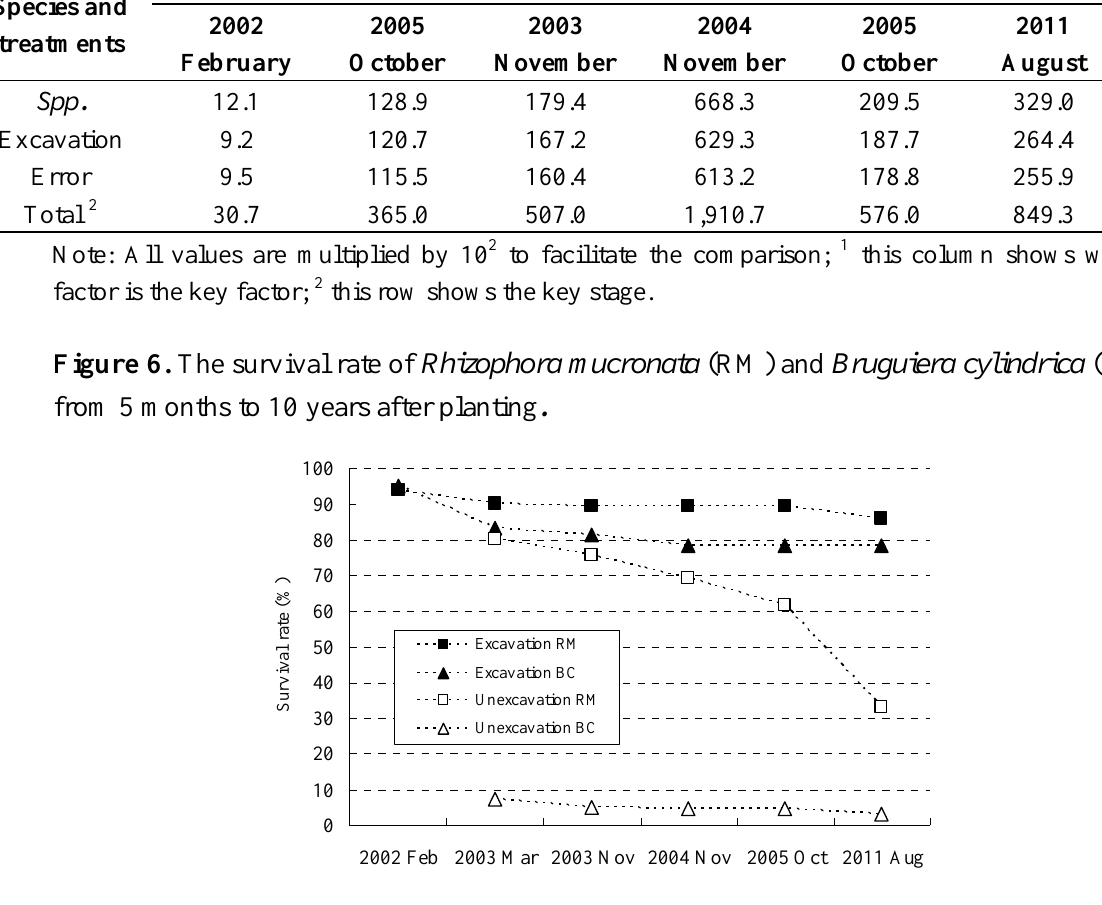
Table 1. Key-factor/key-stage analysis for the survival rates of the planted mangrove species. Species and treatments